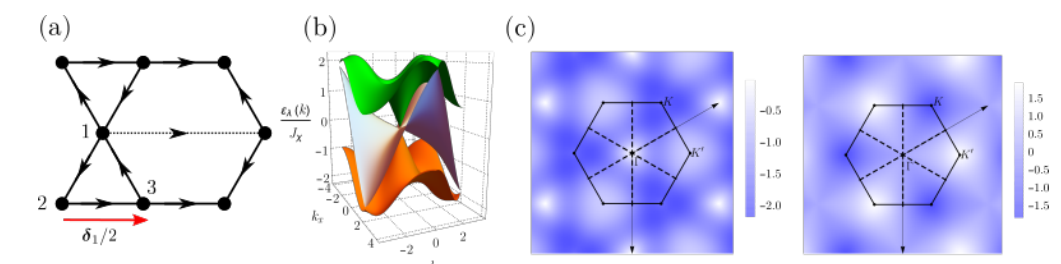
Figure 5: (a) Mean-field ansatz on the kagome lattice. Sites are labeled by the corre- sponding sublattice index s ∈ { 1,2,3 } , see Eq. (9). The arrows on the solid lines indi- = i ξ = i ξ cate the bond direction in which ξ . Likewise, ξ in the direction indi- ij ij d 1 cated by the arrow on the dashed line. The red arrow represents the nearest-neighbor / 2. (b) Three-dimensional plot of the spinon dispersion for κ /κ = 1.2. vector δ d 1 1 ( k ) (left) and the (c) Density plot of the dispersion relations for the lower band (cid:34) 1 ( k ) (right). The dashed lines represent the spinon Fermi surface for middle band (cid:34) 2 the middle